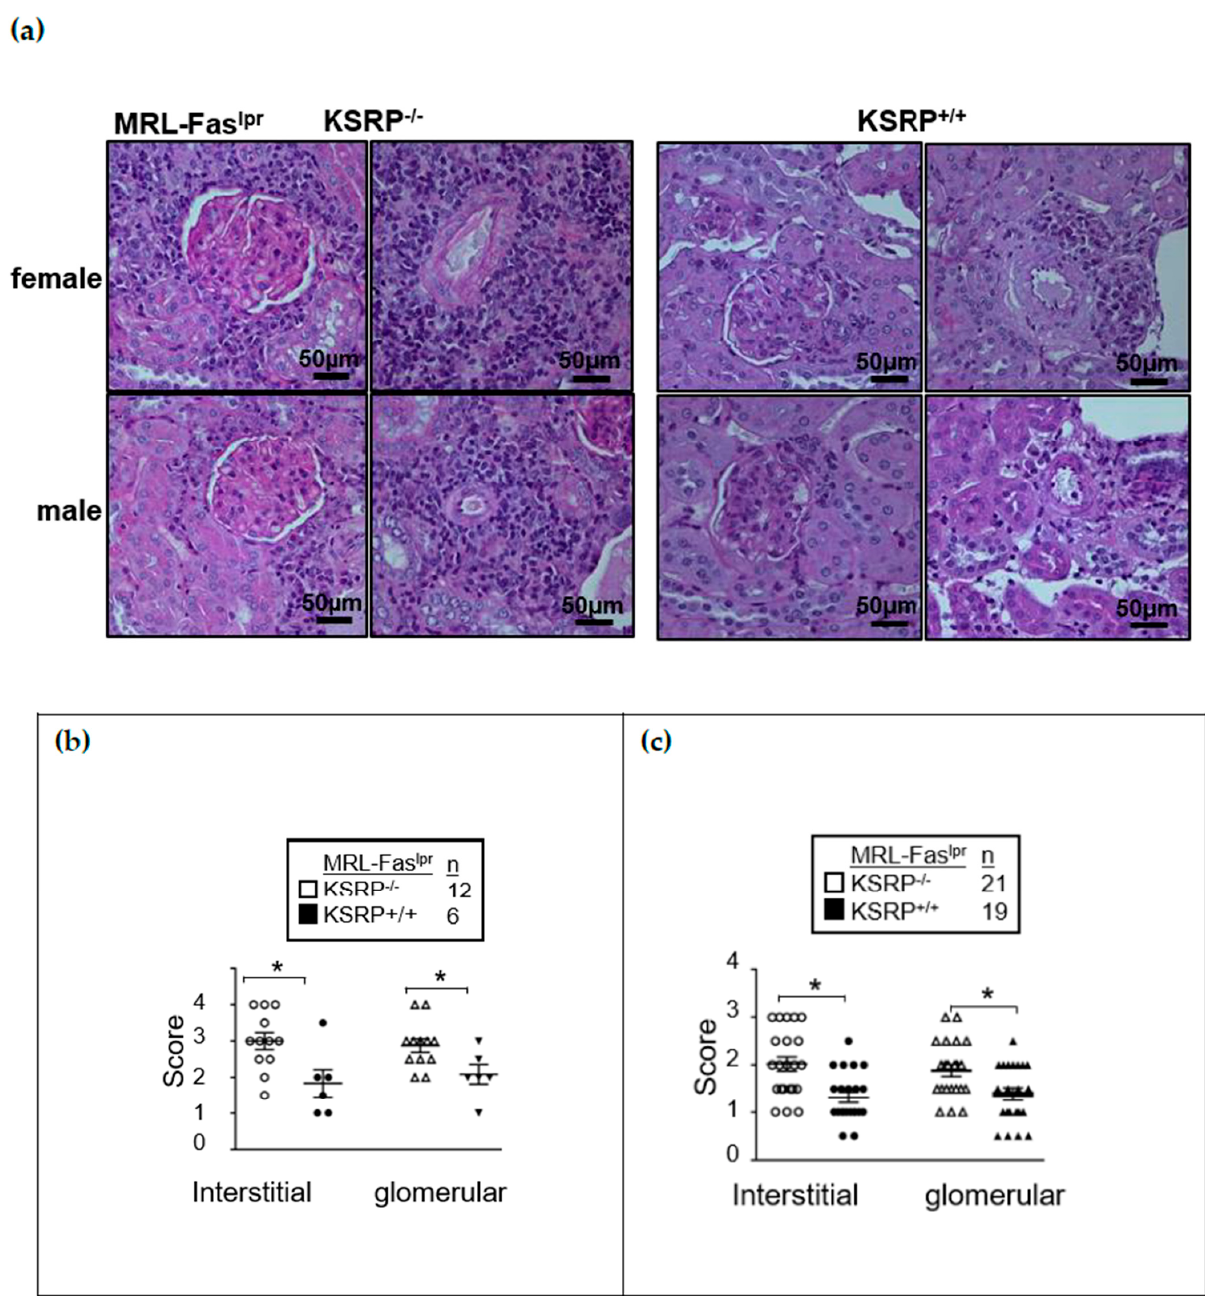
Figure 1. Kidney pathology in MRL-Fas lpr KSRP − / − mice. PAS staining was used to assess glomerular pathology by scoring each glomerulus and periglomerular area on 19-week-old MRL-Fas lpr KSRP +/+ and MRL-Fas lpr KSRP − / − mice, magnification 40×. Data presented are the mean ± SEM of the score with 6 to 12 females ( b ) and 19–21 male animals ( c ) per genotype (* p < 0.05 compared to WT, t -test).